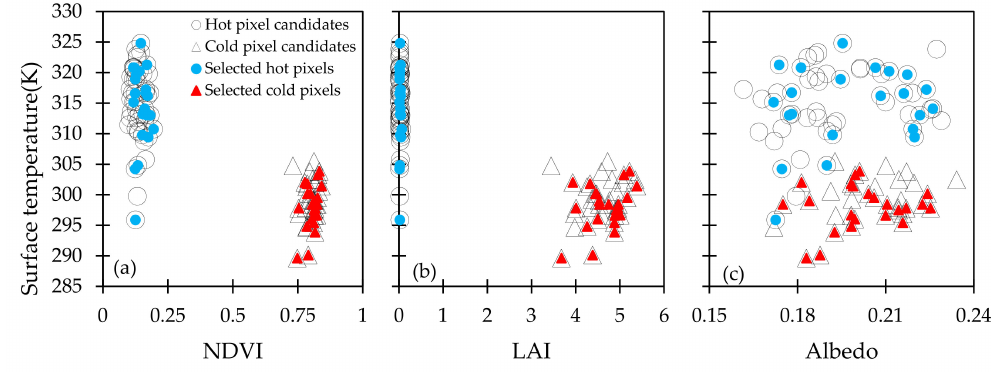
Figure 4. A plot of Surface temperature vs ( a ) NDVI, ( b ) LAI, and ( c ) albedo to depict the hot and cold pixel selection